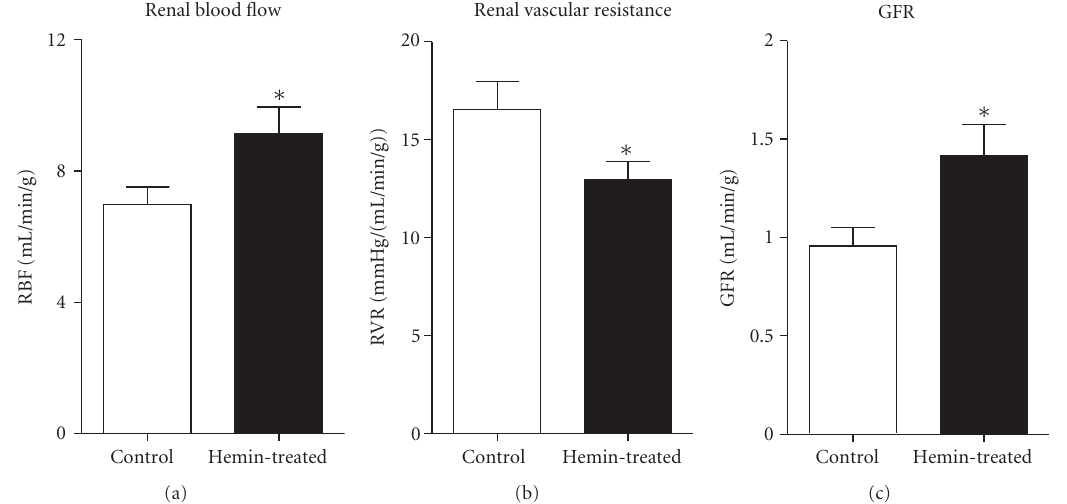
Figure 2: Renal blood flow (RBF), renal vascular resistance (RVR), and glomerular filtration rate (GFR) in hemin-treated rats ( n = 6) compared to control rats ( n = 7). Results are expressed as mean ± SE for each group, ∗ P < 0 . 05 versus Control.